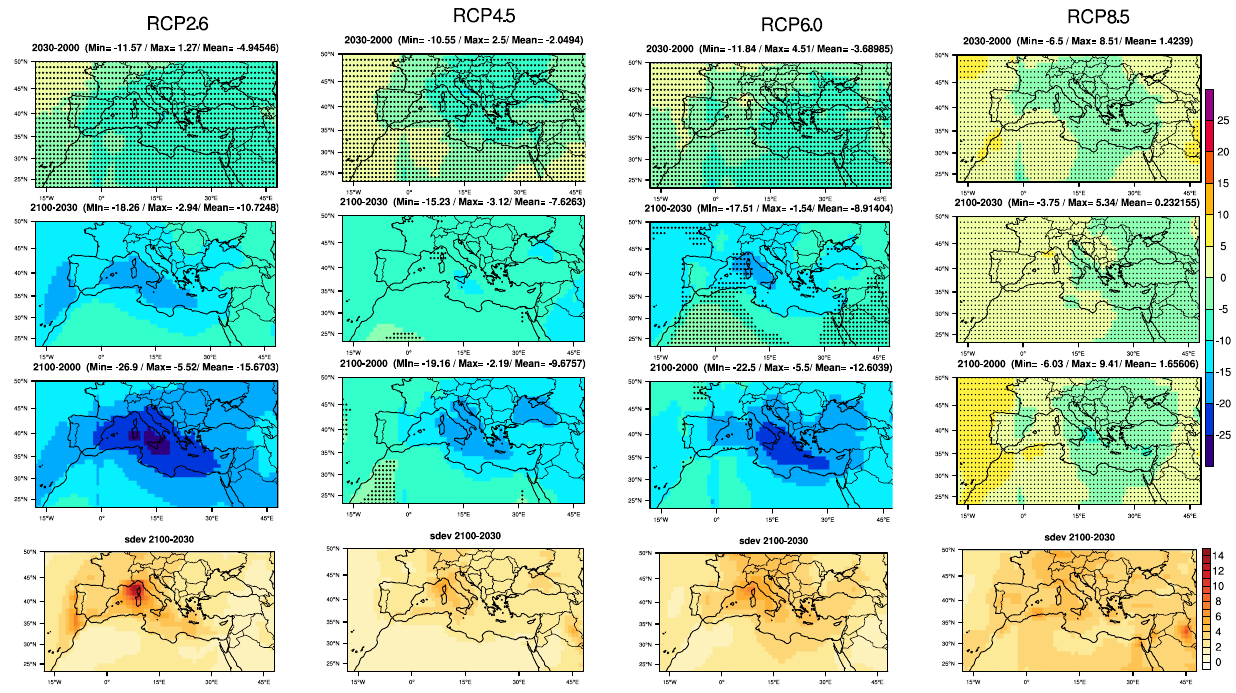
Figure 9. ACCMIP ensemble mean surface ozone change (first to third rows) and standard deviation in ppbv (fourth row) between 2000 and 2100. Each column represents a Representative Concentration Pathway scenario. The rows from top to bottom correspond to anomalies in surface ozone concentration: REF–2030, 2030–2100, REF–2100 and the standard deviation of anomalies 2030–2100, respectively. REF represents the 2000 situation. Black dots indicate regions in the maps with statistically non-significant changes using a field significance test that satisfied the false discovery rate (FDR) criterion with α FDR = 0 . 10. For the first to third rows, red and blue colors represent positive and negative trends, respectively. For the fourth row, red colors represent relatively large standard deviation and white colors represent relatively small standard deviation.